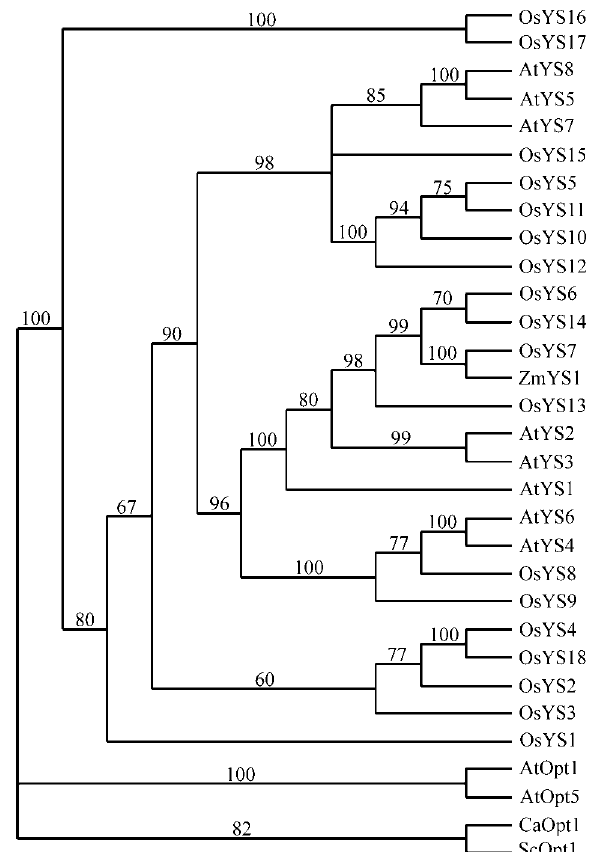
Figure 2 - Phylogenetic analysis of the Yellow Stripe family using PAUP (Swofford, 2002) after alignment of the sequences with Clustal W (Thompson et al. , 1994). The resulting tree shows the relationships be- tween the new 18 members predicted from the rice genome (OsYS) and the eight representatives found in Arabidopsis (AtYS) and the Zea mays YS1 (ZmYS1). Opt members from Arabidopsis (AtOpt), Candida albicans (CaOpt1) and S. cerevisiae (ScOpt1) were joined together as an outgroup. Accession numbers of nucleotide sequences and corresponding predicted OsYS proteins are shown in Table 1. Accession numbers to the other proteins are as follows: ZmYS1: AAG17016; AtYS1: NP_567694; AtYS2: NP_197826; AtYS3: NP_200167; AtYS4: NP_198916; AtYS5: NP_566584; AtYS6: NP_566806; AtYS7: NP_176750; AtYS8: